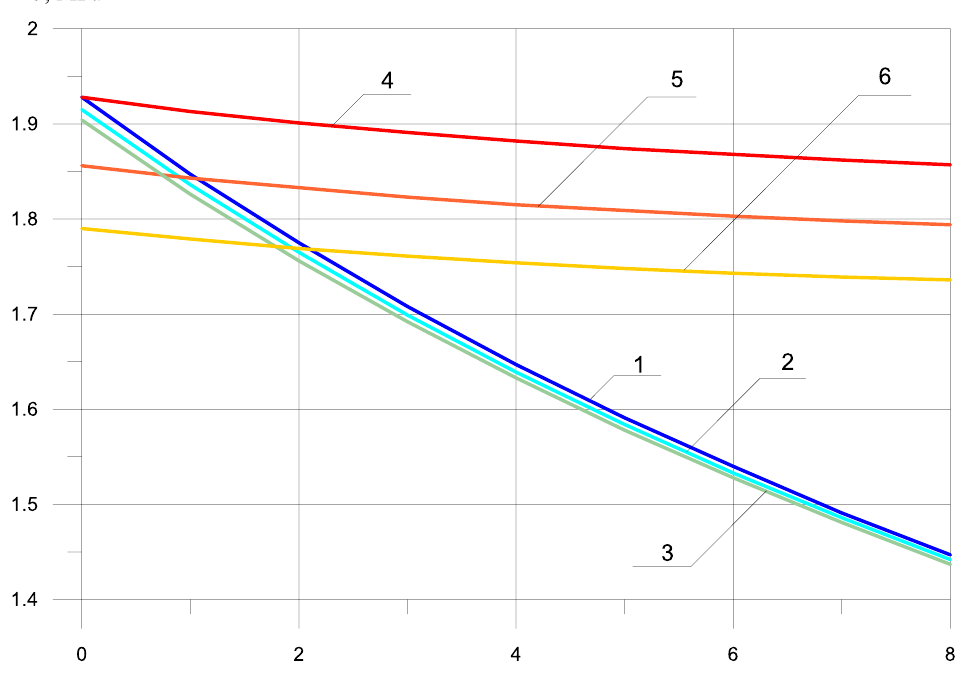
Figure 2. Dynamic stresses excluding bimodularity depending on the number of bars in the zone under tension, excluding the beam mass: (1) σ t at n c = 0; (2) σ t at n c = 2; (3) σ t at n c = 4; (4) σ c at n c = 0; (5) σ c at n c = 2; (6) σ c at n c =